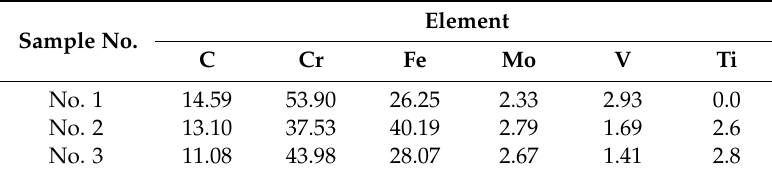
Table 4. EDS ‐ analyzed results of compound containing titanium (mass %). Table 3. EDS-analyzed results of carbides containing chromium (mass %).